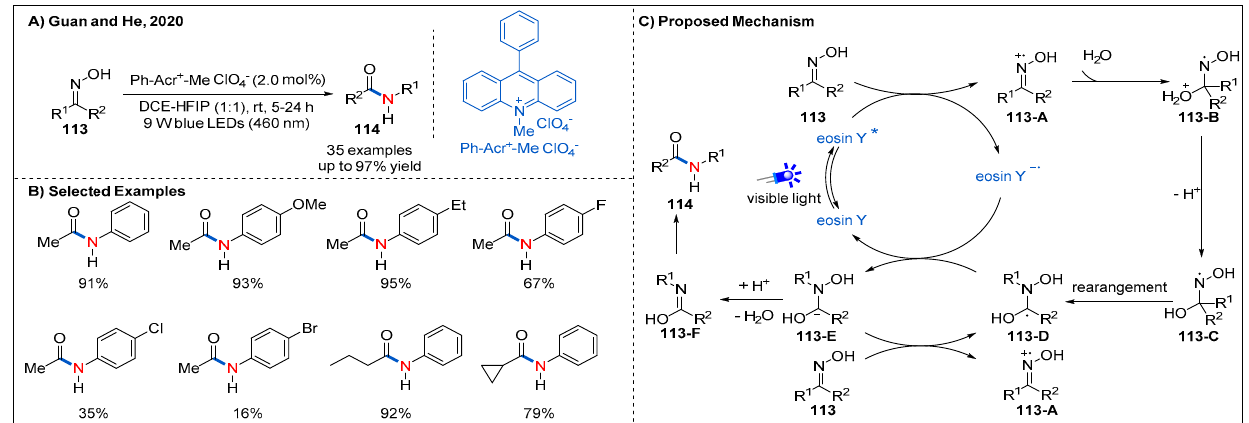
Figure 33. Photoinduced Beckmann rearrangement.